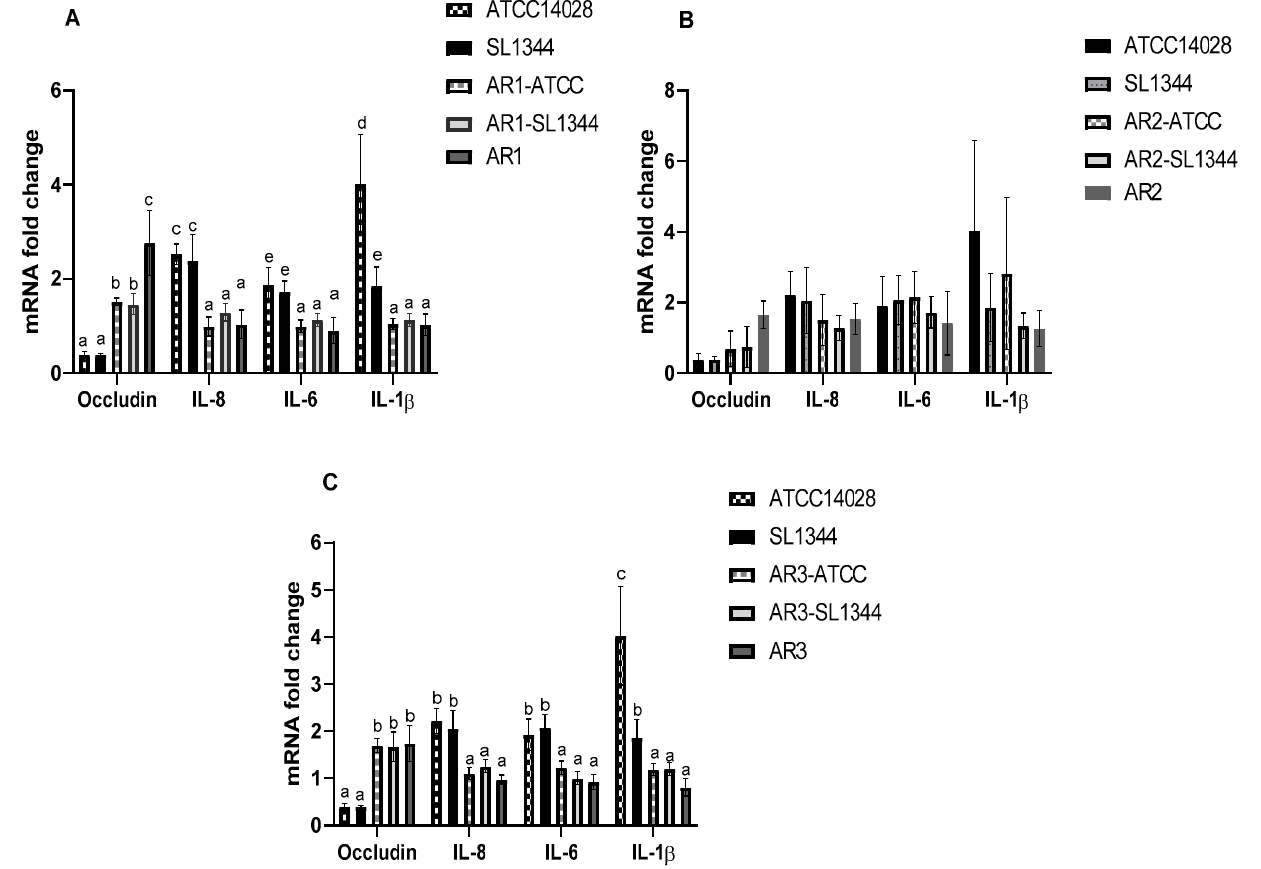
Figure 14. Modulatory effects of L. acidophilus AR1 ( A ), L. acidophilus AR2 ( B ), and L. fermentum AR3 ( C ) on different gene expression during pathogenic infection. Different letters show significant values